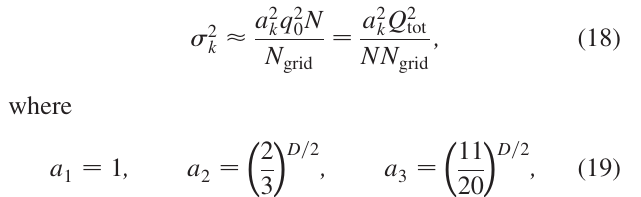
TABLE I. Values of a